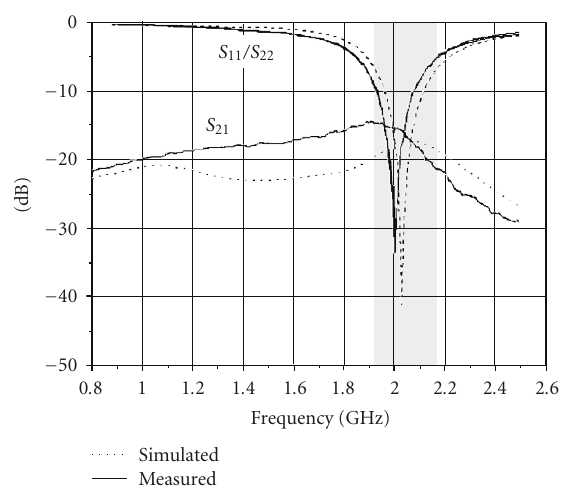
Figure 6: Simulated and measured S -parameters of the two- antenna system with the line between the PIFA feeding